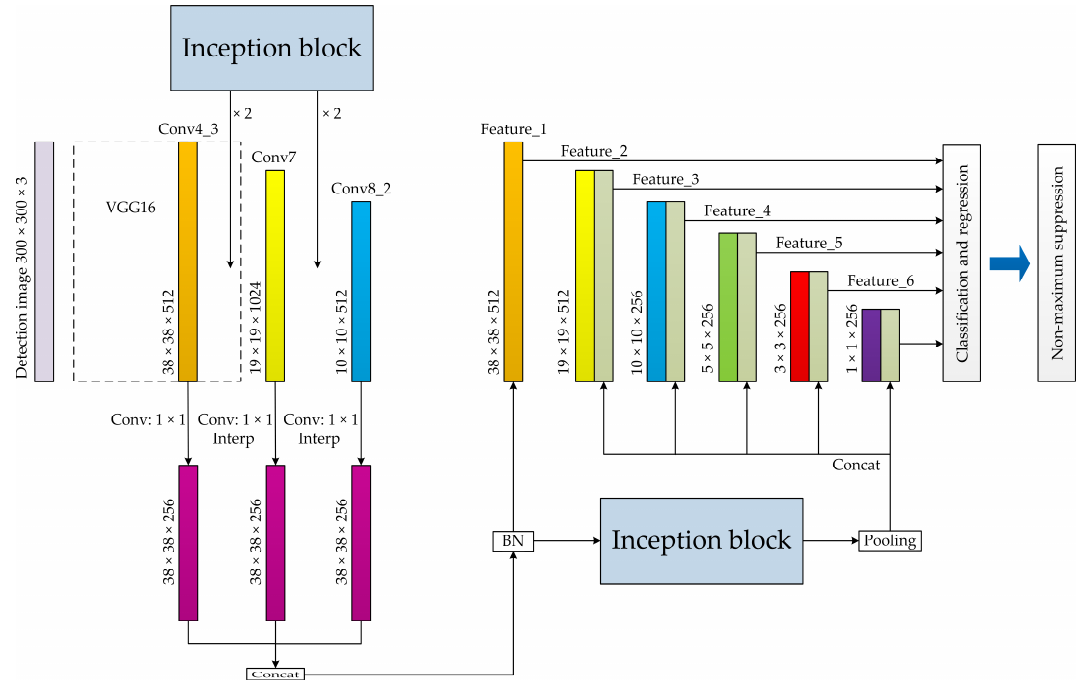
Figure 2. The basic structure of the improved SSD network model.